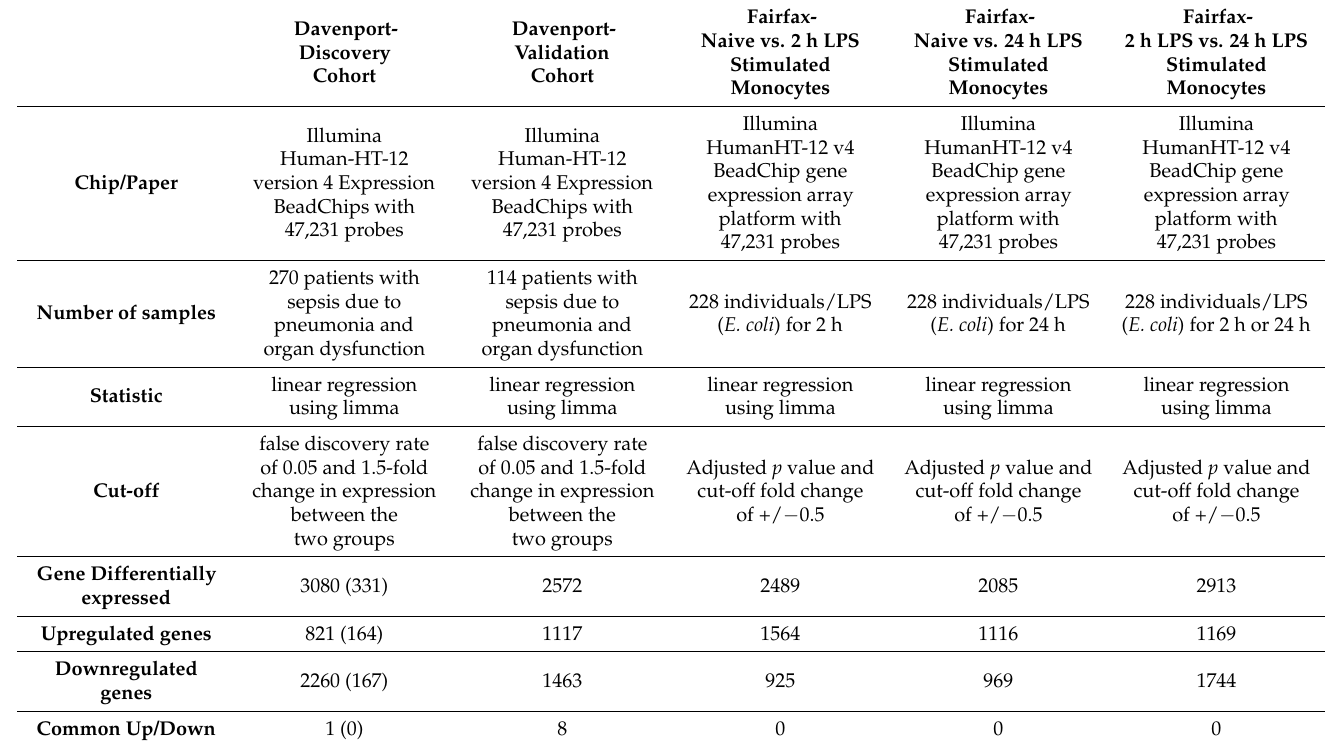
Table 2. Characteristics of human datasets in the articles of Davenport et al. [26] and Fairfax et al.